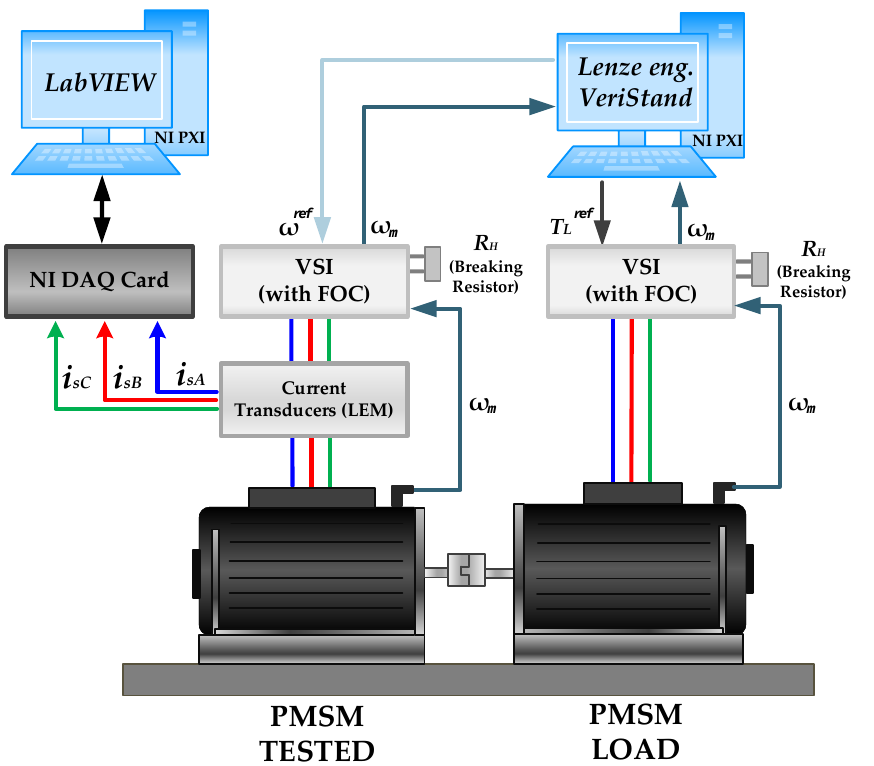
Figure 6. Block diagram of the experimental setup.